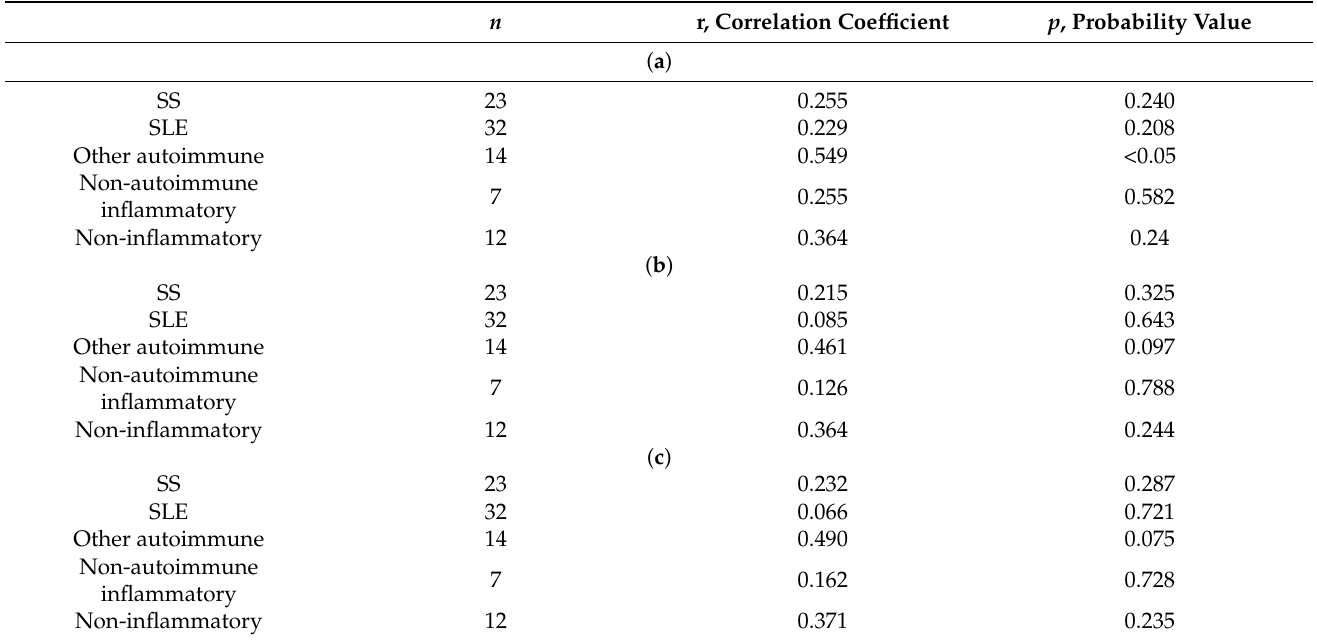
Table 3. ( a ) Correlation by Spearman-Rho of circulating anti-NR2 antibody titer and cognitive fatigue severity in the different groups of patients with rheumatic diseases. ( b ) Correlation by Spearman-Rho of circulating anti-NR2 antibody titer and motor fatigue severity in the different groups of patients with rheumatic diseases. ( c ) Correlation by Spearman-Rho of circulating anti-NR2 antibody titer and total fatigue severity in the different groups of patients with rheumatic diseases. n r, Correlation Coefficient p , Probability Value ( a )